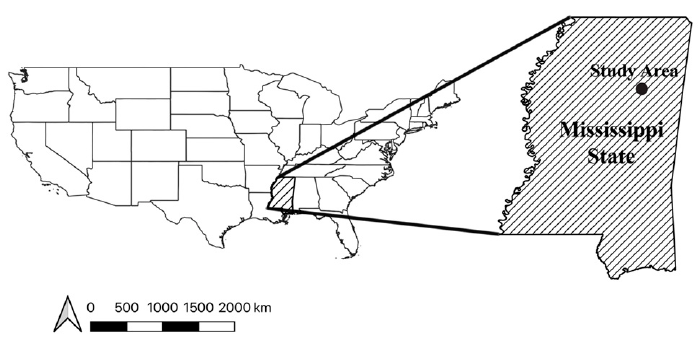
Figure 1. Geolocation of the study area monitored during the growing season.